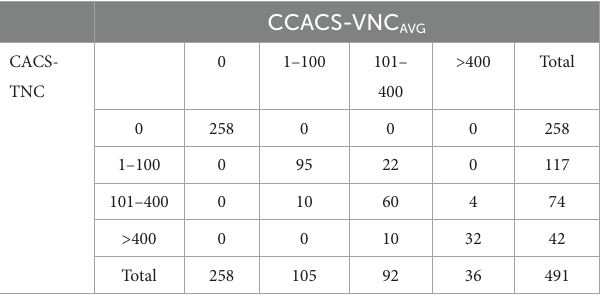
TABLE 5 Comparison of the Agatston calcium scoring risk rating between the CACS-TNC and CCACS-VNC branches .